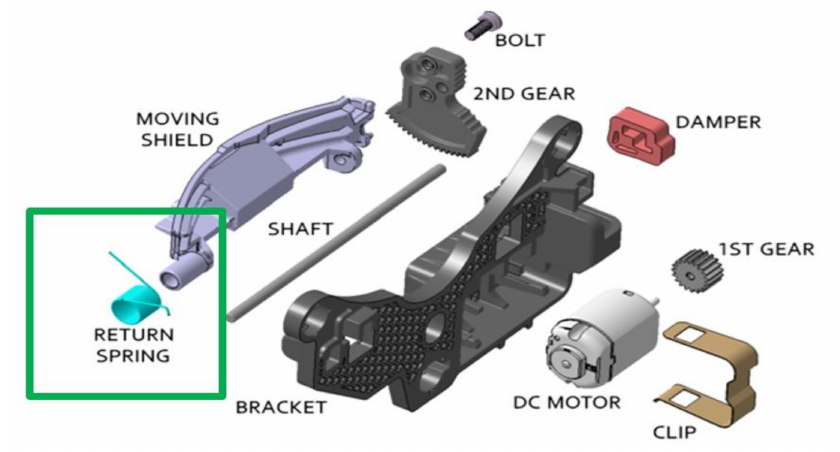
Figure 1. Bi-functional DC motor system in an automobile.